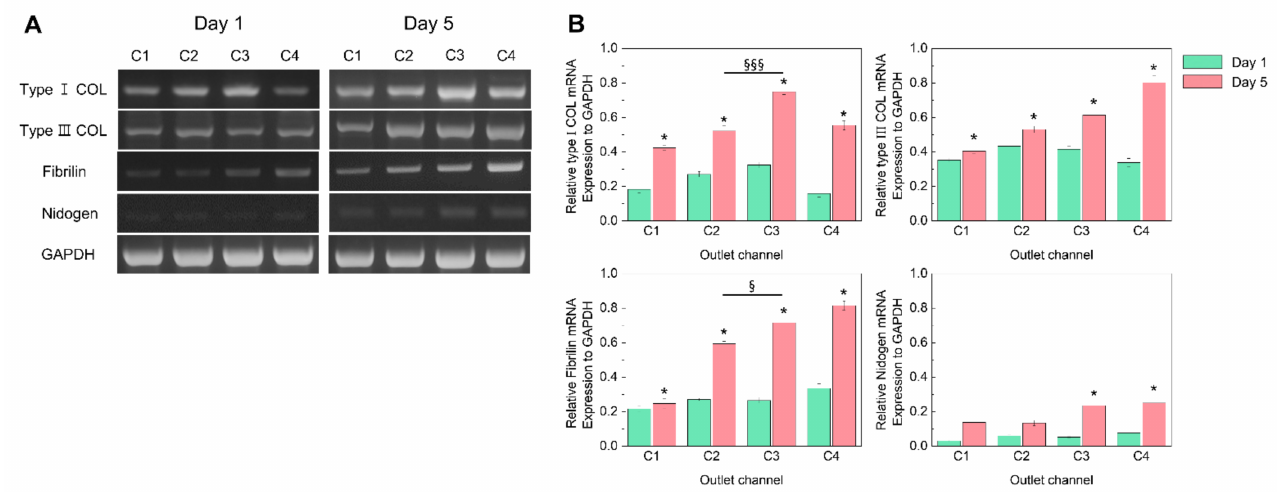
Figure 5. ( A ) Representative agarose gel showing mRNA expression of ECM-associated genes in MCTs generated from droplet system for days 1 and 5. ( B ) Quantification of expression of Type I and III collagen, fibrilin, and nidogen relative to GAPDH from day 1 to day 5. Data are represented as mean ± standard deviation of 3 independent experiments. * indicates p < 0.05 for day 1 vs. day 5, § indicates p < 0.05 for C2 vs. C3 in day 5, and §§§ indicates p < 0.001 for C2 vs. C3 in day